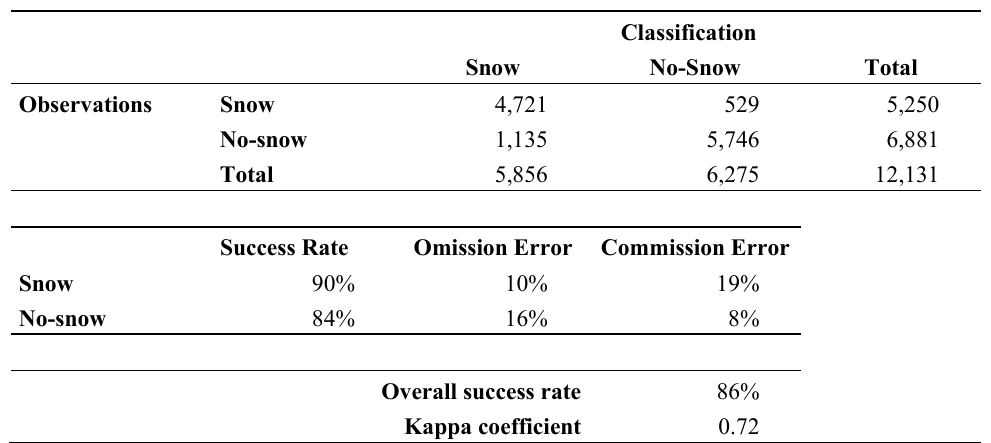
Table 6. Validation of the merging algorithm using snow ground observations from the 20 validation meteorological stations for the period